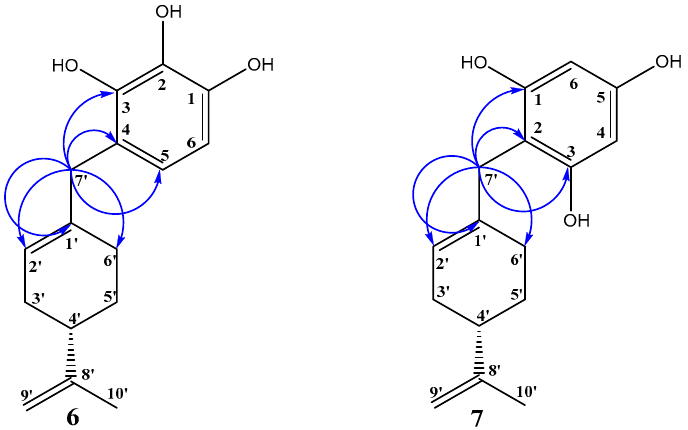
Figure 2. Most important correlations 2D 1 H– 13 C HMBC of compounds 6 and 7 .